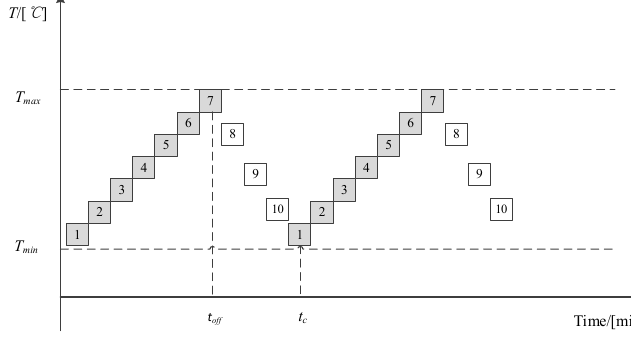
Figure 2. The state of the air-conditioning load (ACL).